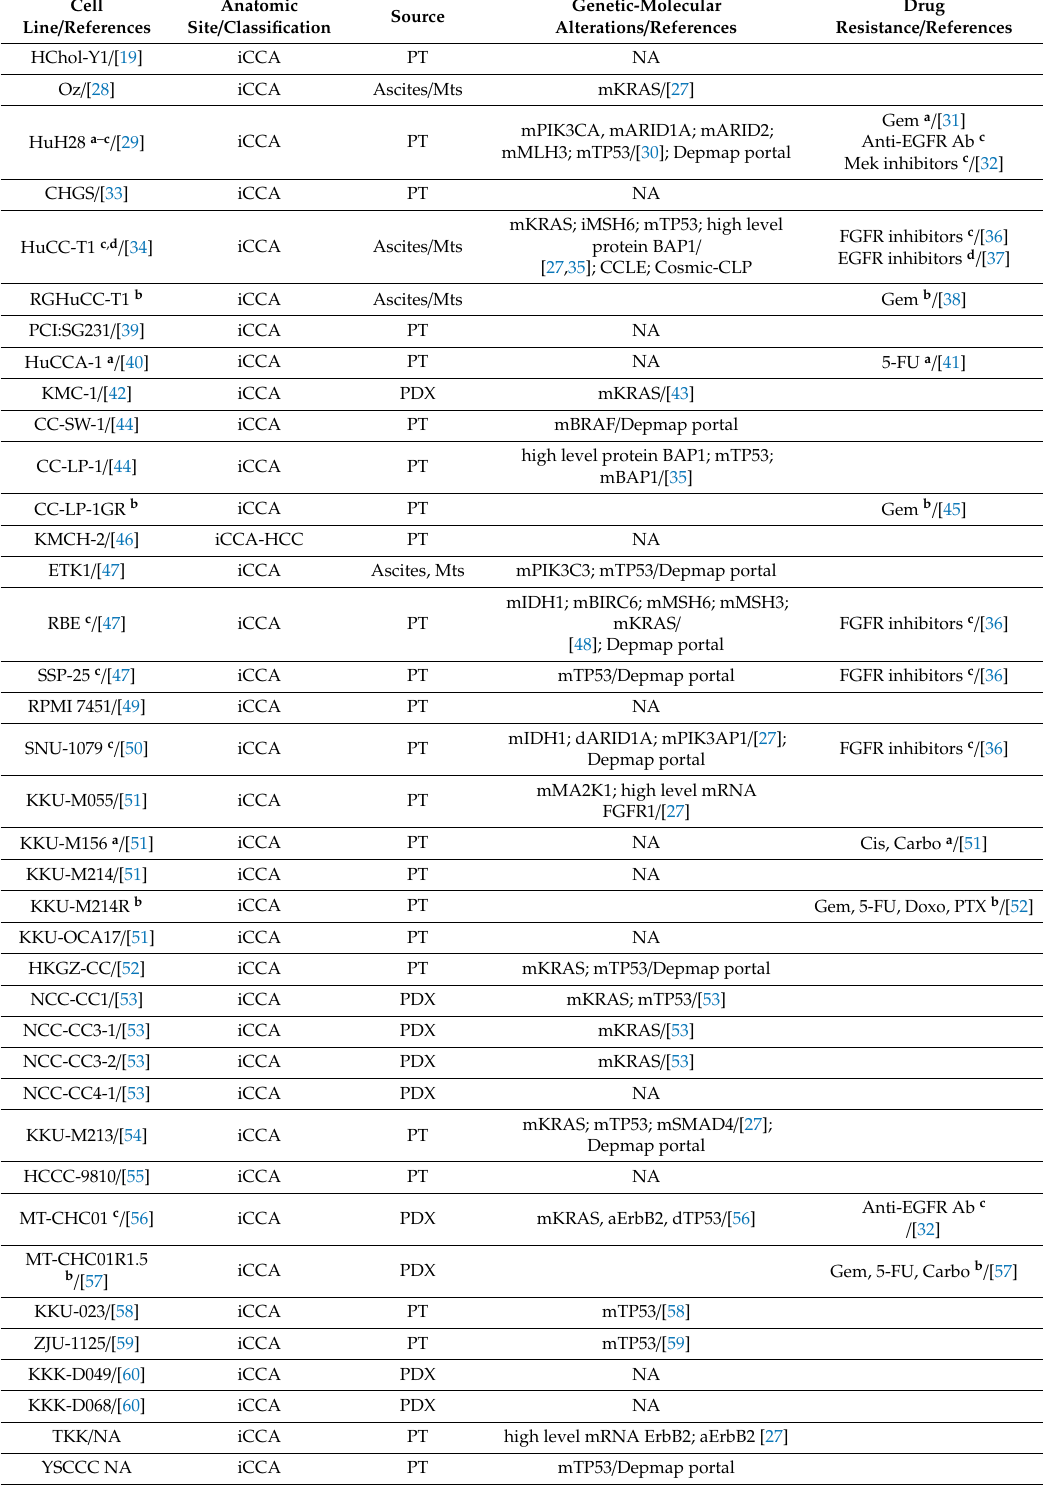
Cholangiocarcinoma (CCA) cell lines described in the literature and some of their genetic / molecular characteristics and drug